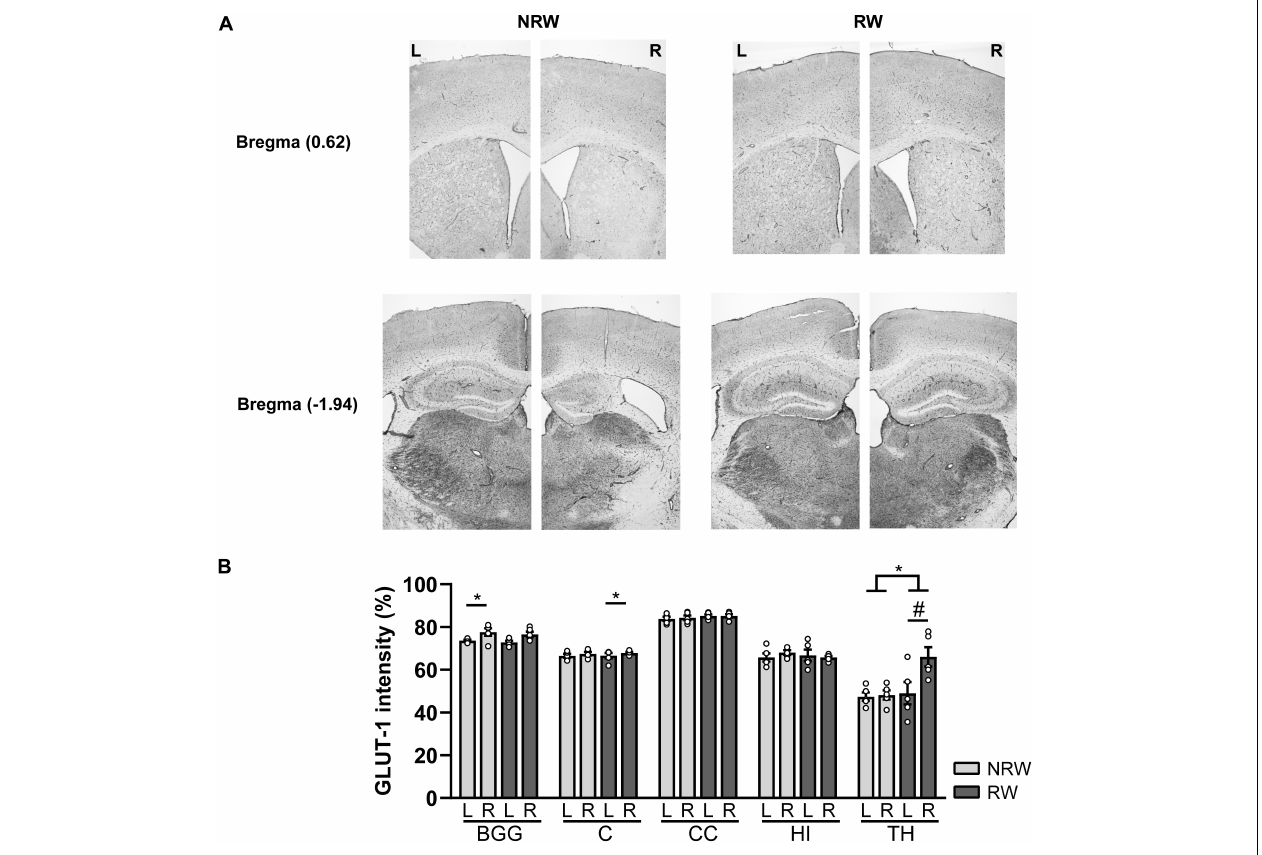
FIGURE 10 | Immunohistochemical staining for GLUT-1 in brains of mice with (RW) and without a running wheel (NRW) 1 week after stroke induction. (A) Representative images of the GLUT-1 staining in the ipsilateral (R: right) and contralateral hemisphere (L: left) of bregma –1.94 and 0.62 in RW and NRW mice. (B) GLUT-1 intensity measured in different ROI (BGG: basal ganglia, C: cortex, CC: corpus callosum, H: hippocampus, TH: thalamus). RW: N = 5, NRW: N = 5; values represented in mean ± SEM. # 0.05 < p < 0.08 (tendency); * p ≤